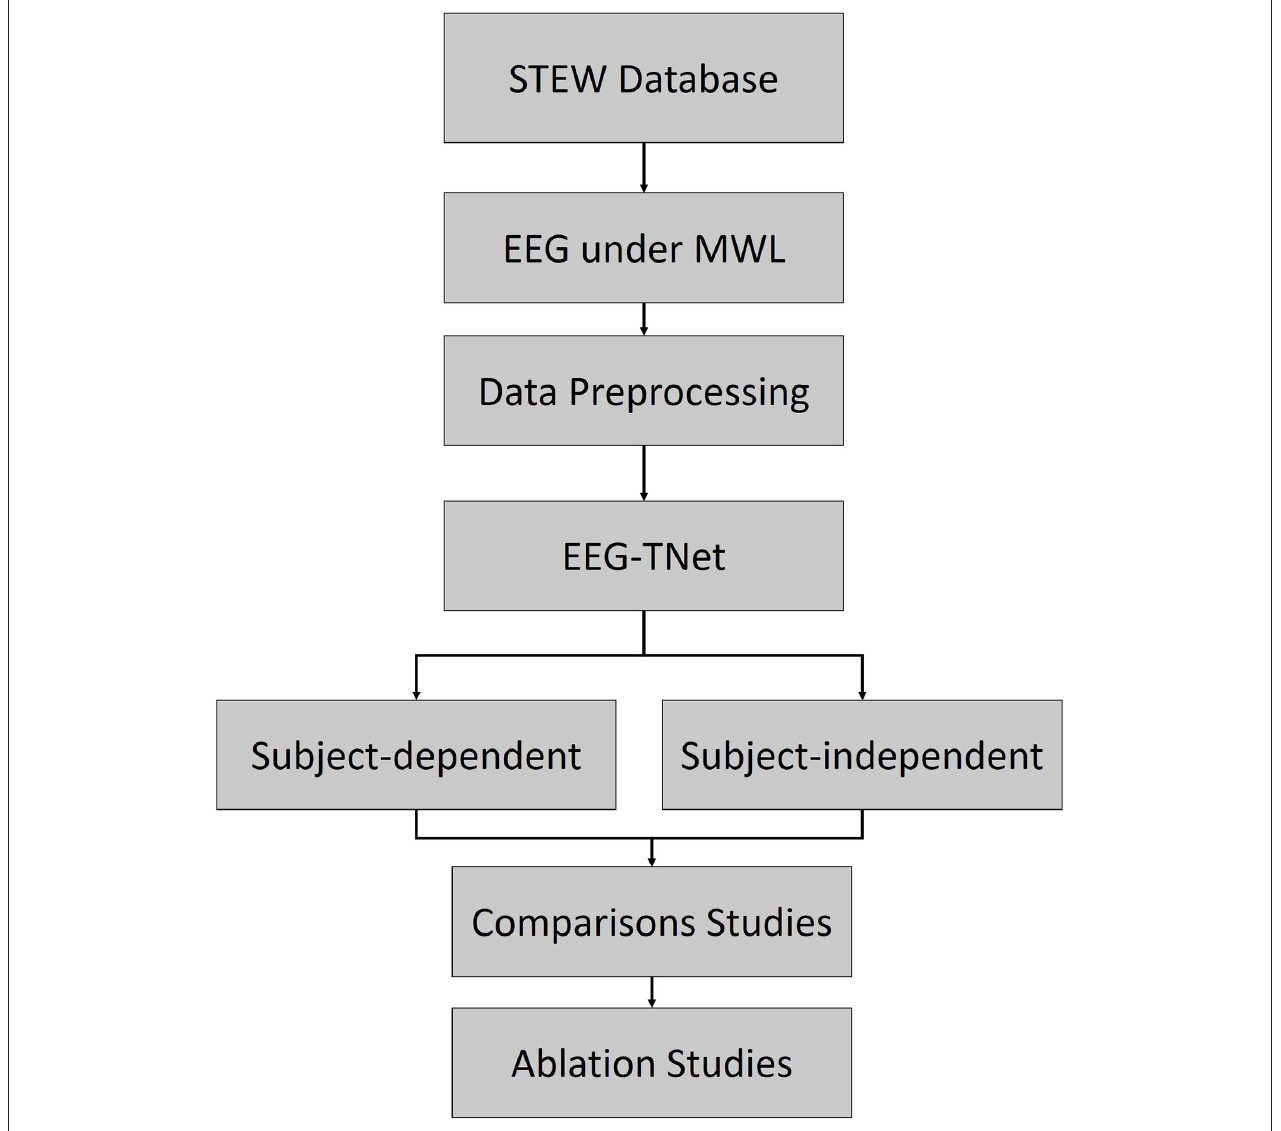
FIGURE 1 | The detailed flowchart of this